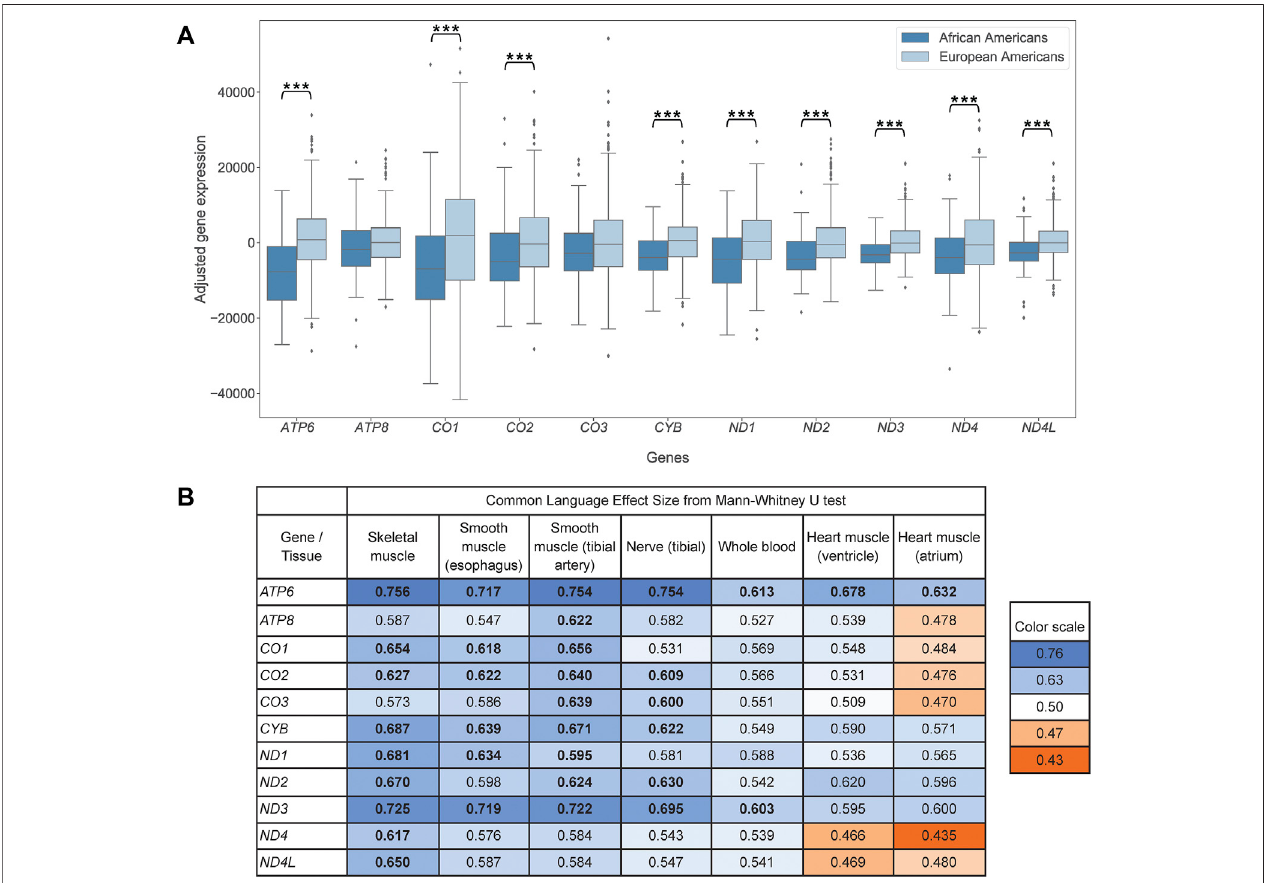
FIGURE2|(A) Pairwise boxplot ofskeletalmuscle mtDNAgeneexpression inAfricanAmericans( n =85)and EuropeanAmericans ( n =580),adjustedbyage and ischemic time. Stars indicate signi fi cant results ( p < 0.05) of one-sided, Bonferroni-corrected Mann-Whitney U test of mean ranks (* indicates p < 0.05, ** indicates p < 0.01, *** indicates p < 0.001). (B) Mann-Whitney U test common-language effect sizes comparing adjusted mtDNA gene expression between African Americans and EuropeanAmericansforskeletalmuscle,smoothmuscle(esophagus),artery(tibial),nerve(tibial),wholeblood,andheart(ventricleandatrium).Boldvaluesindicate signi fi cantdifference( p < 0.05)usingaone-sided,Bonferroni-correctedMann-WhitneyUtestofmeanranks.p-valuesarelistedin SupplementaryTableS5 .Valueson the blue background, above 0.5, support lower adjusted expression with higher mitonuclear DNA discordance, consistent with our hypothesis; values on the